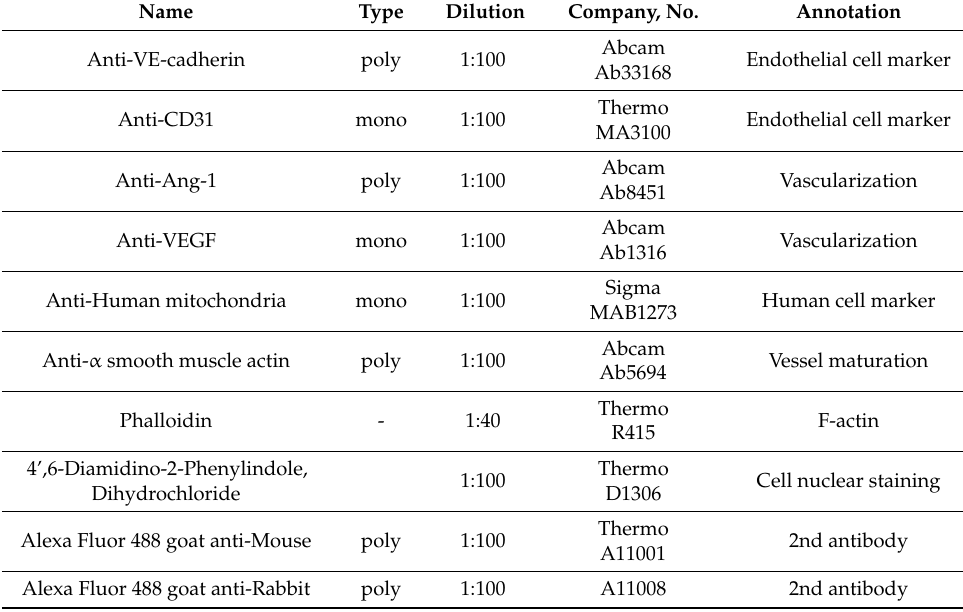
Table 2. Materials used for immunofluorescence